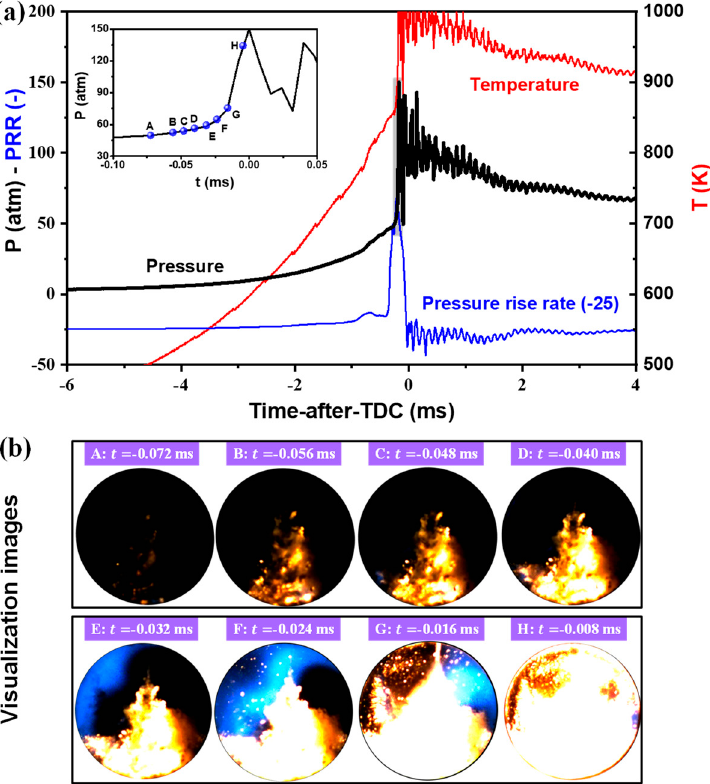
Figure 5. Traces of pressure, pressure rise rate, and temperature and visualization images of abnormal combustion at P c = 40 atm, δ = 1.5 ms, and P J = 60 MPa (corresponding to case (b) shown in Figure 3). ( a ) Pressure and pressure rise rate and ( b ) visualization images.